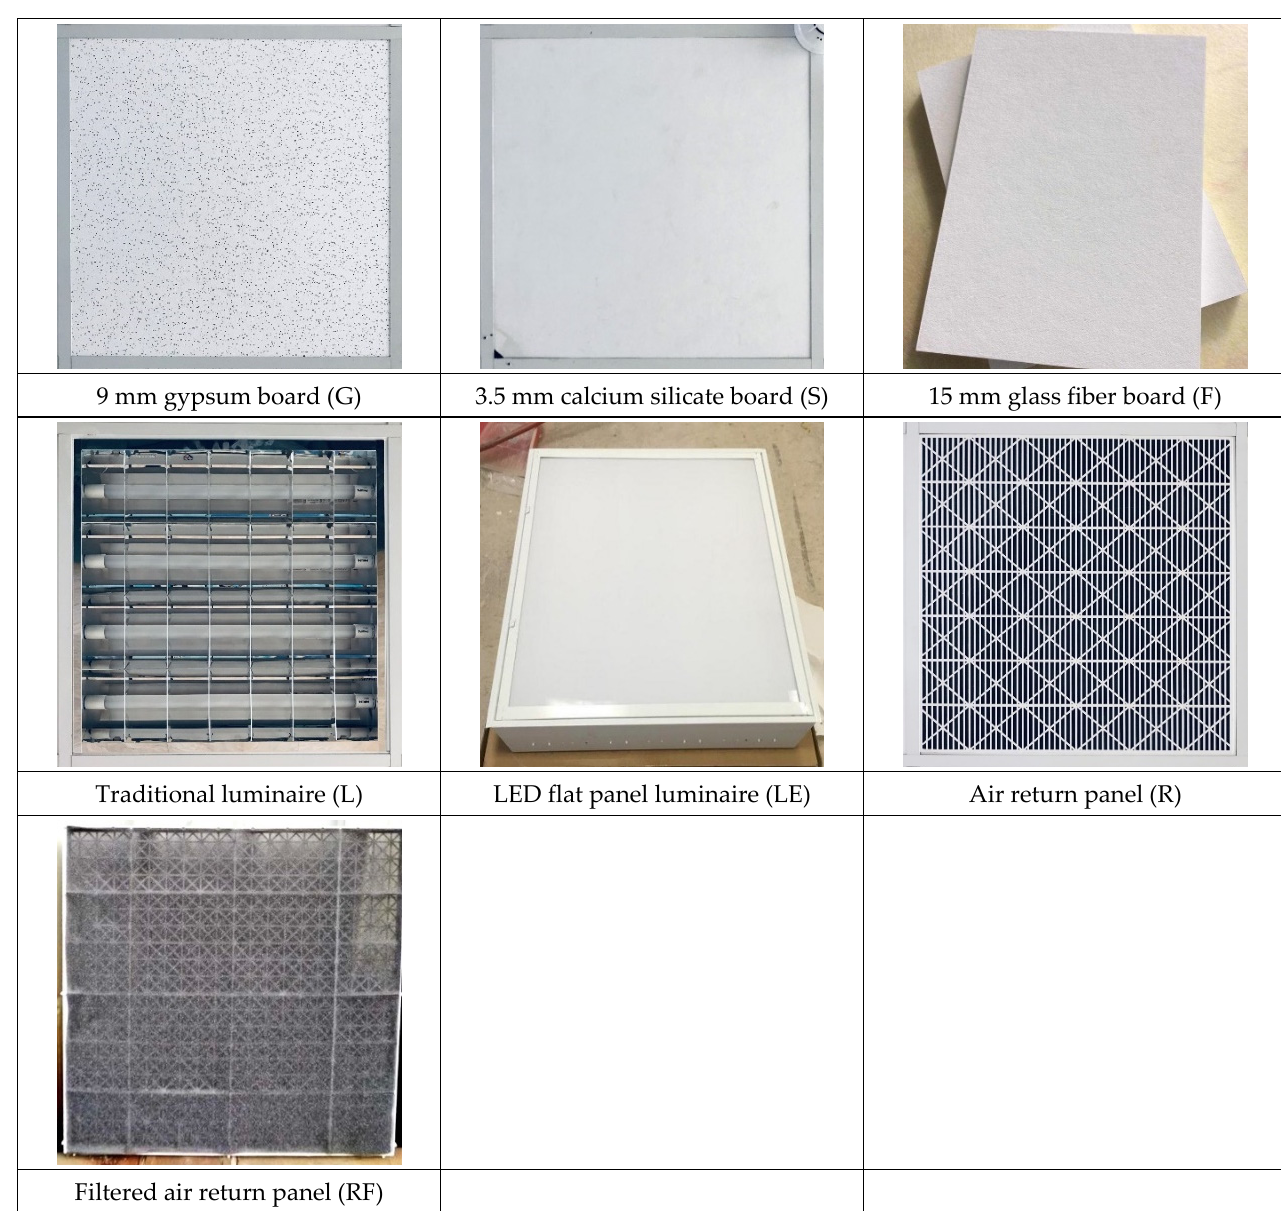
Figure 8. Ceiling specimen numbering diagram. Table 1. Average leakage volume (m 3 /h) of each specimen at each pressure difference and with different smoke flow directions.